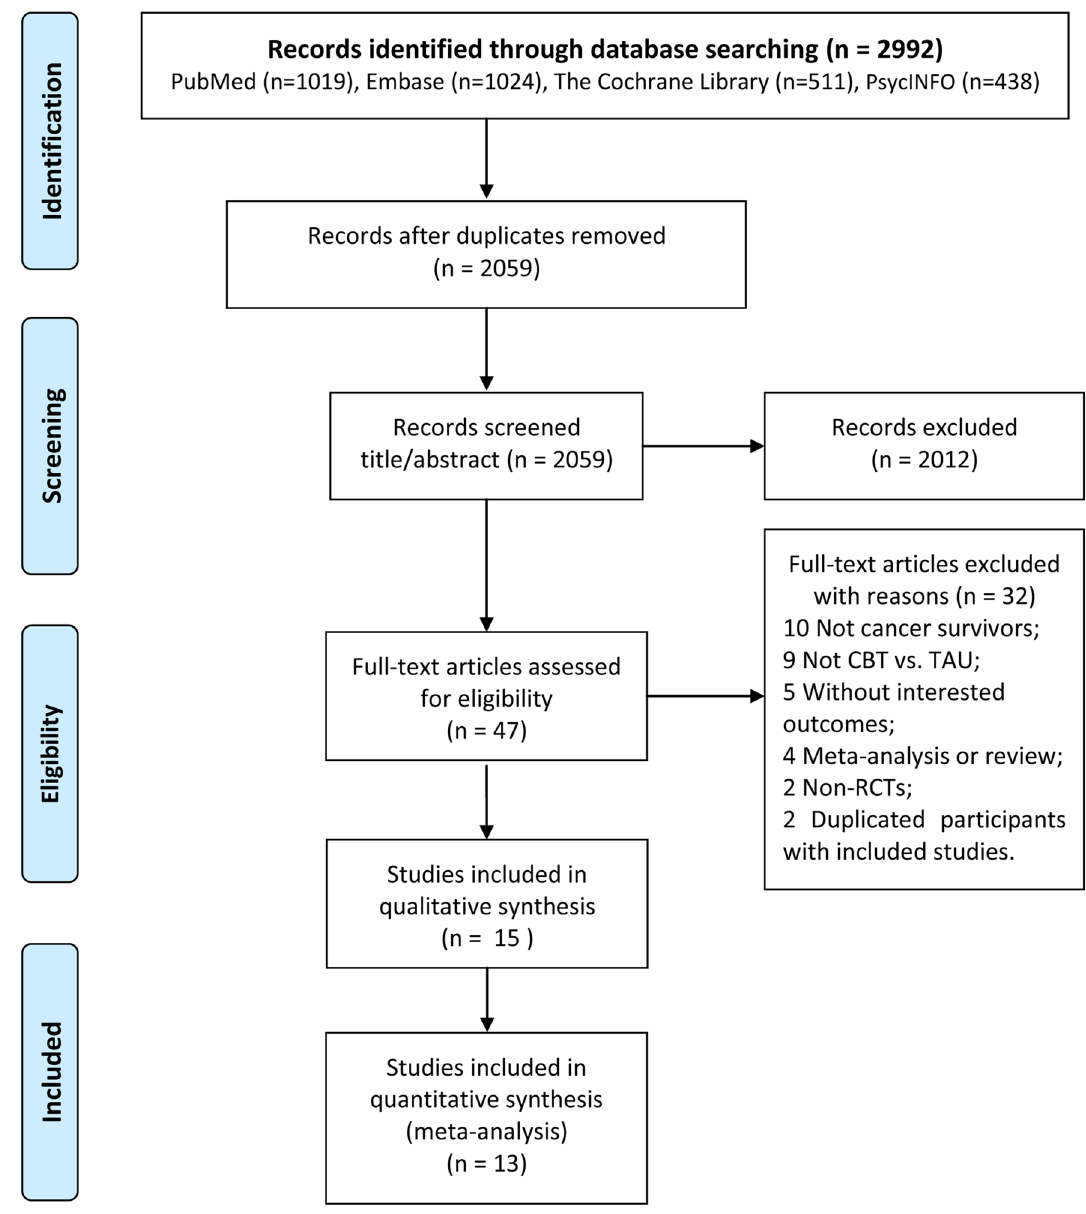
Figure 1. Selection process for the trials included in the meta-analysis. CBT cognitive behavioral therapy, TAU treatment as usual, RCT randomized controlled